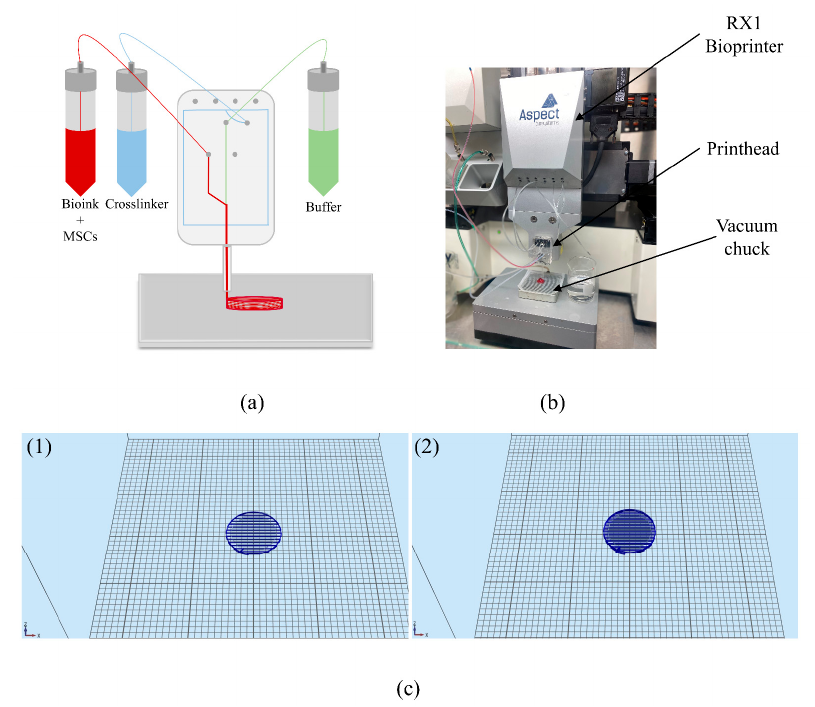
Figure 1. ( a ) Schematic representation of the Aspect Biosystems LOP TM print-head technology; ( b ) Lay-out of bioprinter while printing constructs. ( c ) infill pattern of bioprinted constructed; ( 1 ) is one layer and ( 2 ) is two layers.